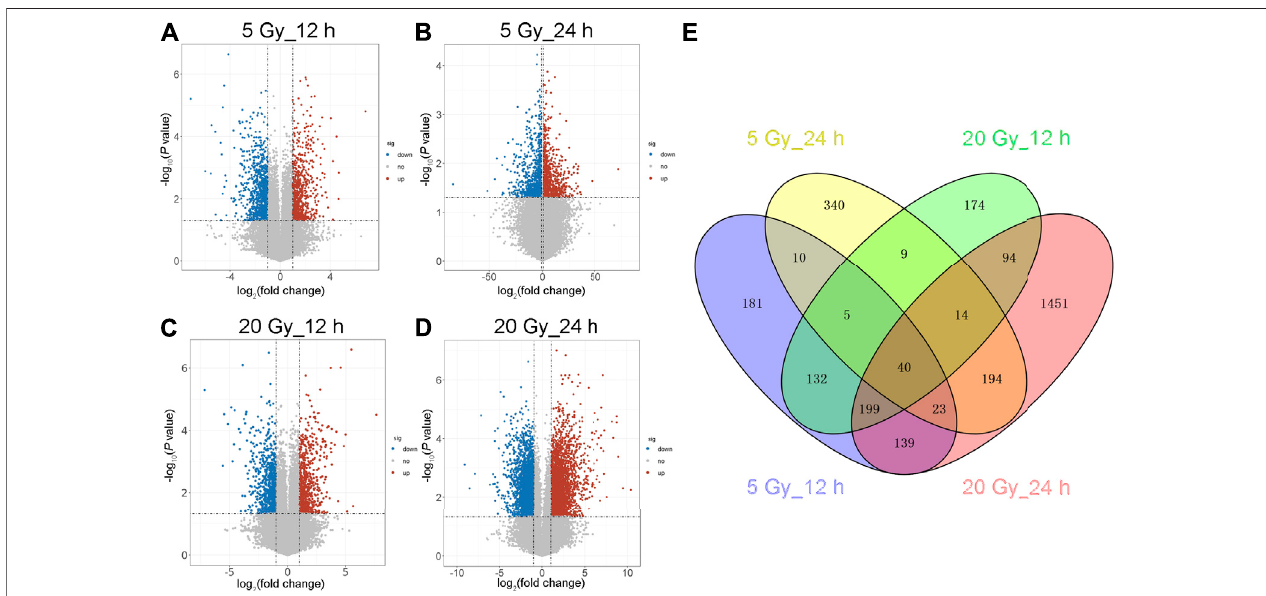
FIGURE 2 | Volcano map and Venn diagram of differentially expressed genes (DEGs). (A – D) Volcano maps showing an overview of the differentially expressed transcripts (DEG cut points: corrected- P < 0.05 and absolute fold change ≥ 1.5) at the indicated x-ray dose (5 or 20 Gy) and time after exposure (12 or 24 h). Red dots representsigni fi cantlyupregulatedgenes;bluedots,downregulatedgenes;graydots,nosigni fi cantchange. (E) VenndiagramoftheDEGsinthefourirradiatedgroups. Blue shows 729 DEGs 12 h after 5 Gy; yellow, 635 DEGs 24 h after 5 Gy; green, 667 DEGs 12 h after 20 Gy; and red, 2,154 DEGs 24 h after 20 Gy. The intersection of the four groups has 40